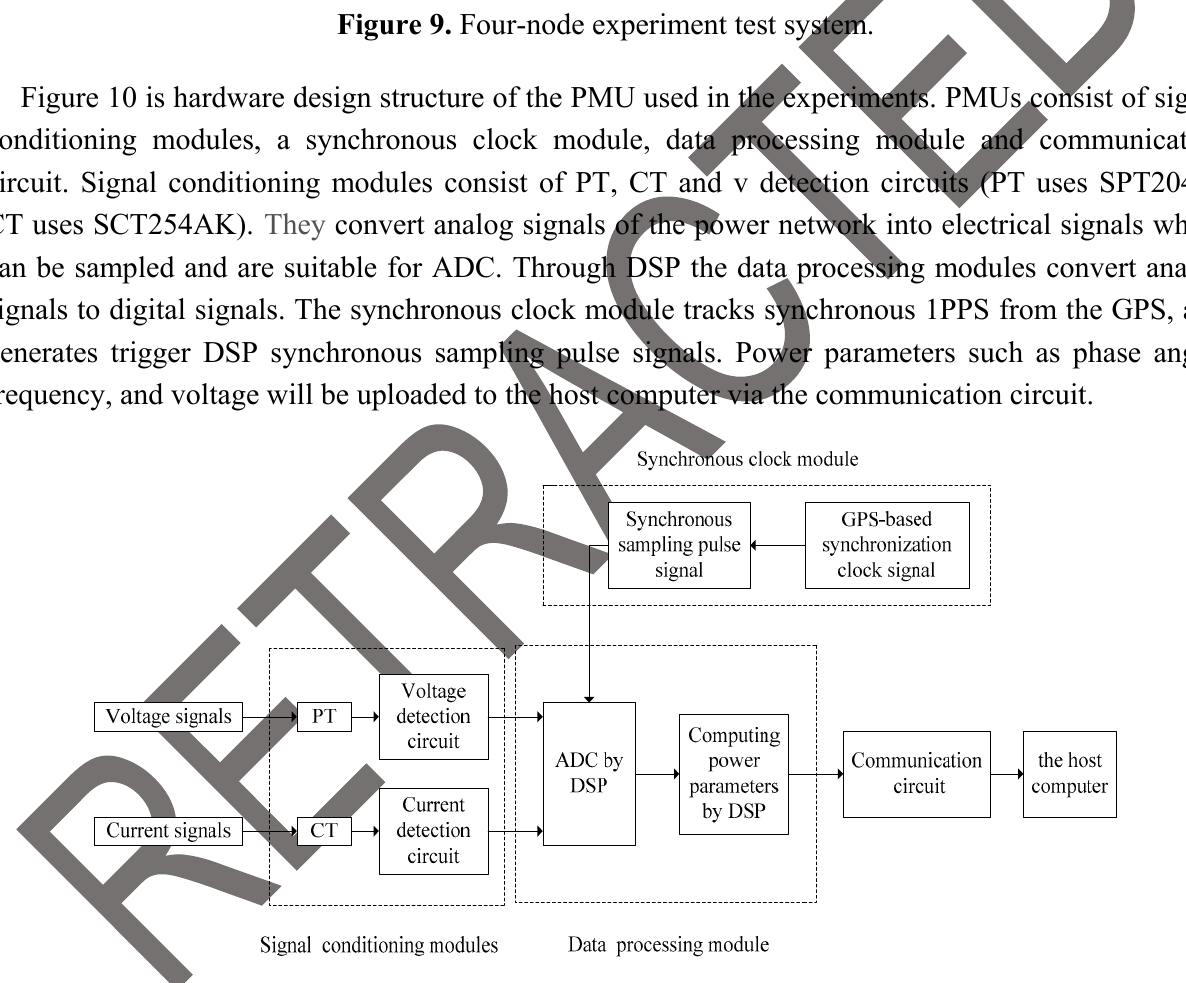
Figure 9. Four-node experiment test system.